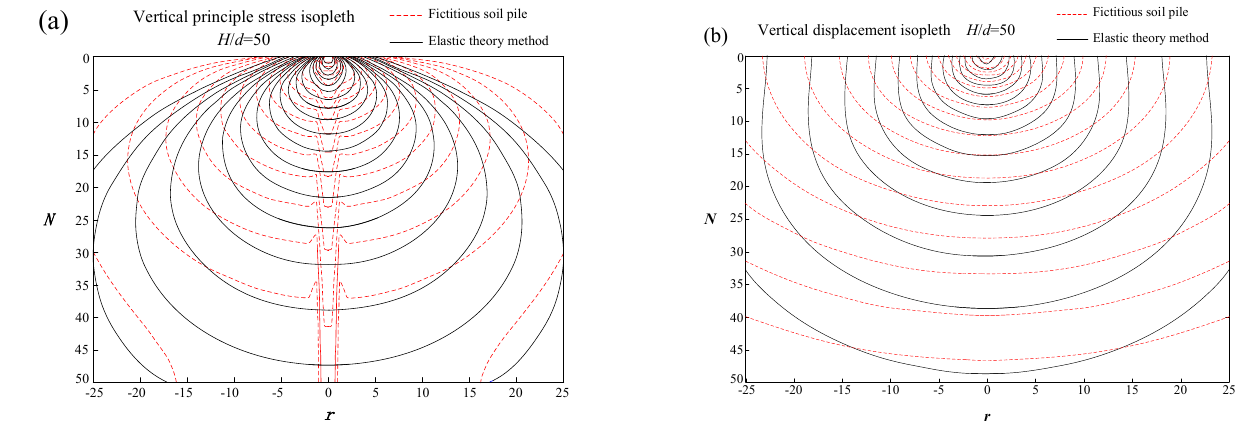
Figure 8. Stress and displacement of soil calculated by the fictitious soil pile model and the rigorous elastic theory: ( a ) principle stress; ( b ) displacement.